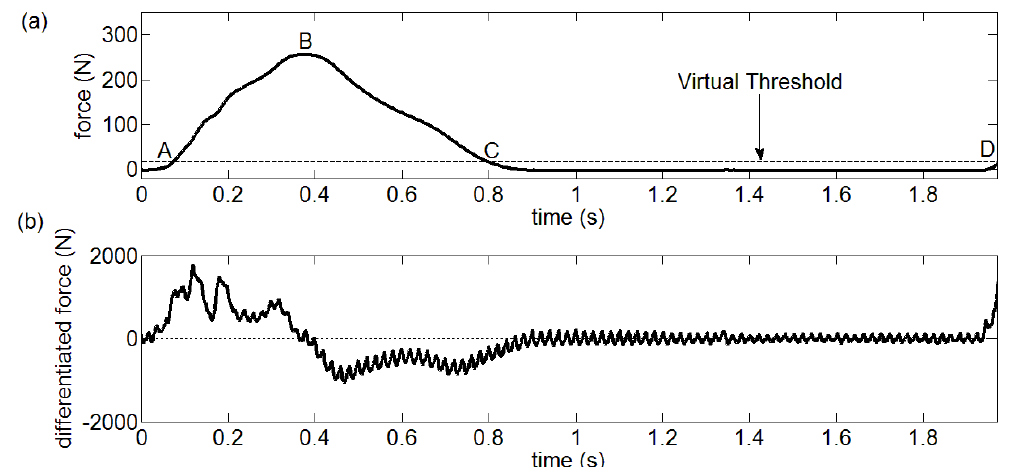
Figure 2. ( a ) Using virtual threshold to divide the GCF into on-ground and off-ground statuses, ( b ) The differential GCFs are used to identify the References [A B], [B C] and [C D].